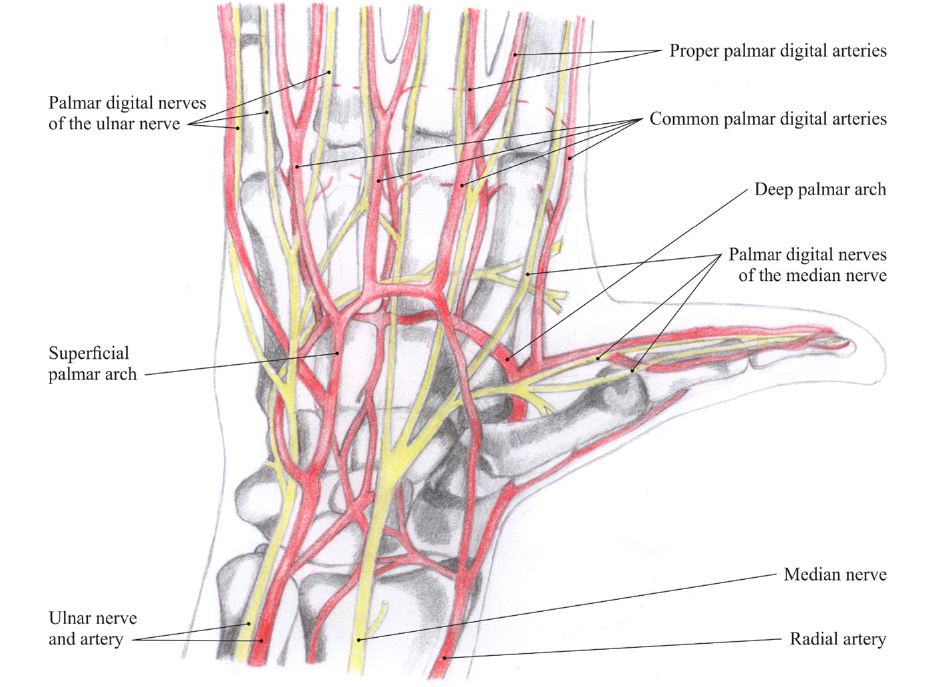
Figure 1. Nerves and arteries of the hand